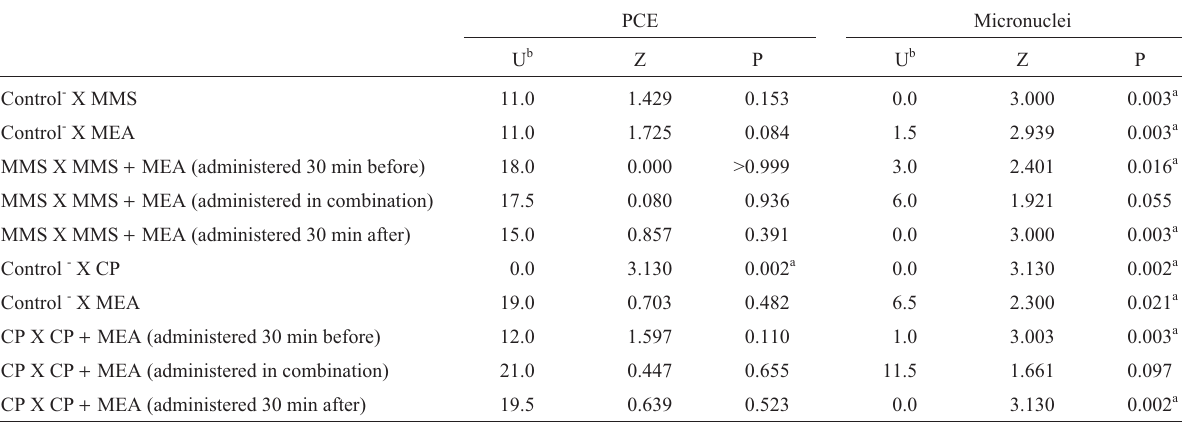
Table 3 - Comparison of the various samples by the Mann-Whitney